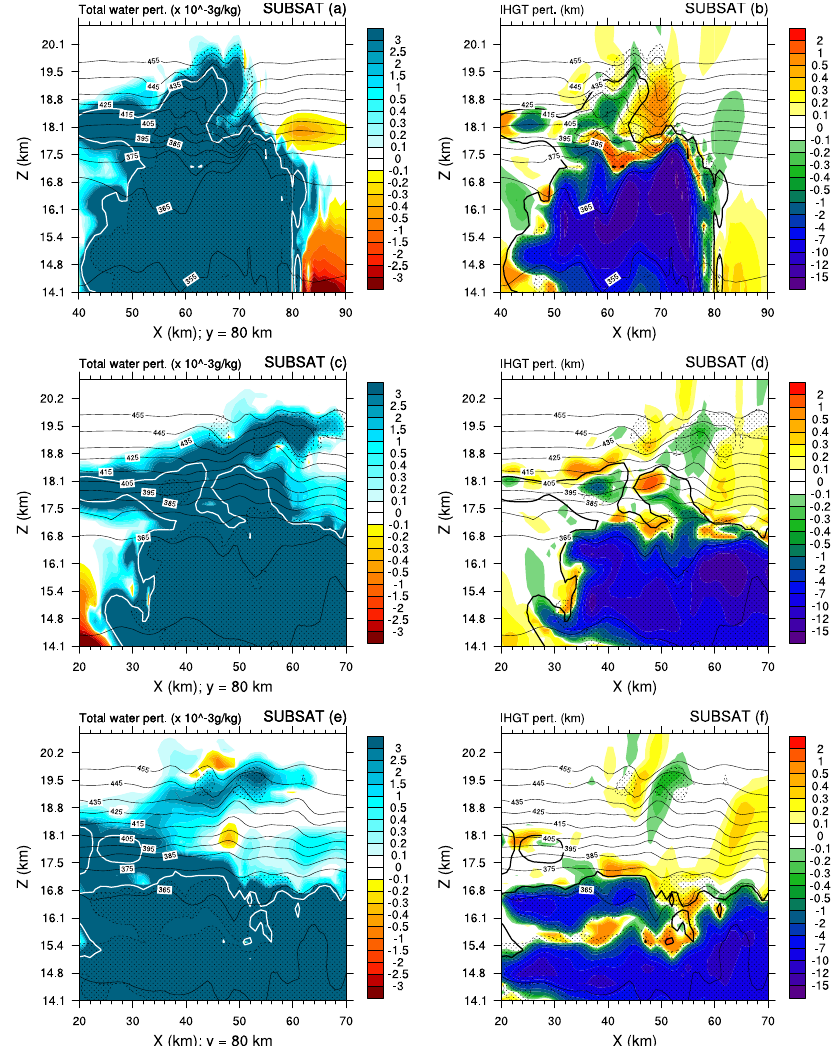
Fig. 12. Vertical cross-sections of total water and IHGT tracer perturbations in the SUBSAT case, taken at (a, b) 50min, (c, d) 60min and (e, f) 70min, along y = 80km, following the time of maximum overshoot (t = 40min). Potential temperatures isolines, contoured every 10K, are overlaid from 355–400K. Stippled regions correspond to where parameterised TKE per unit mass exceeds 0.05m 2 s − 2 . The thick white or black line represents the total cloud mixing ratio of 0.01gkg − 1 . Note that the horizontal locations of (a) and (b) are different to